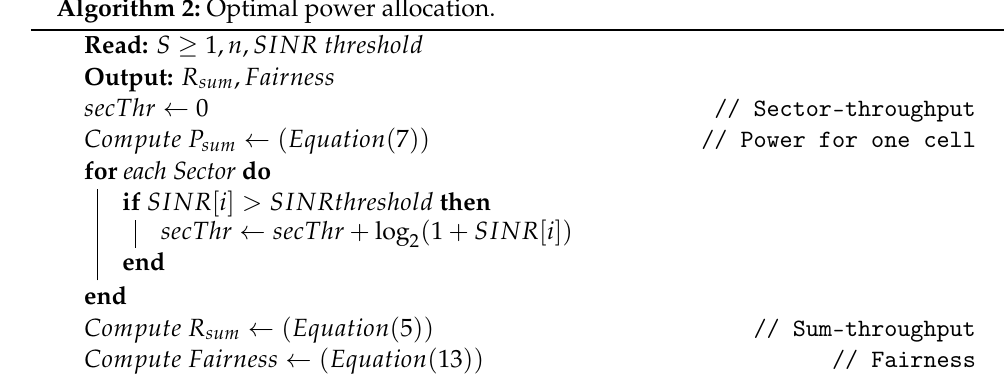
Algorithm 2: Optimal power